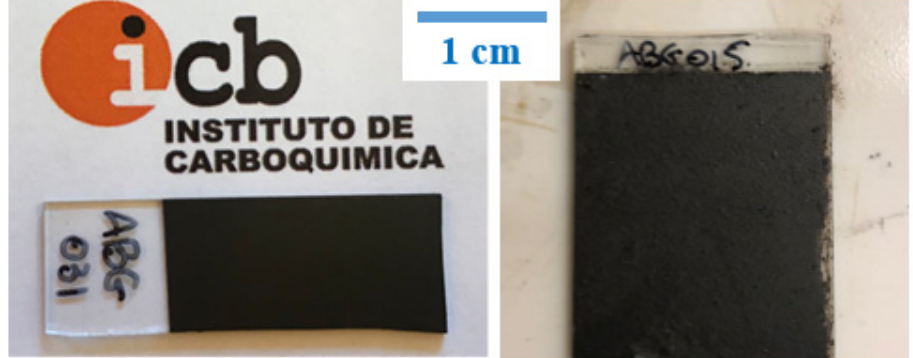
Figure 4. Photographs of films made from low-viscosity inks (left) and high-viscosity pastes (right) on glass substrates.